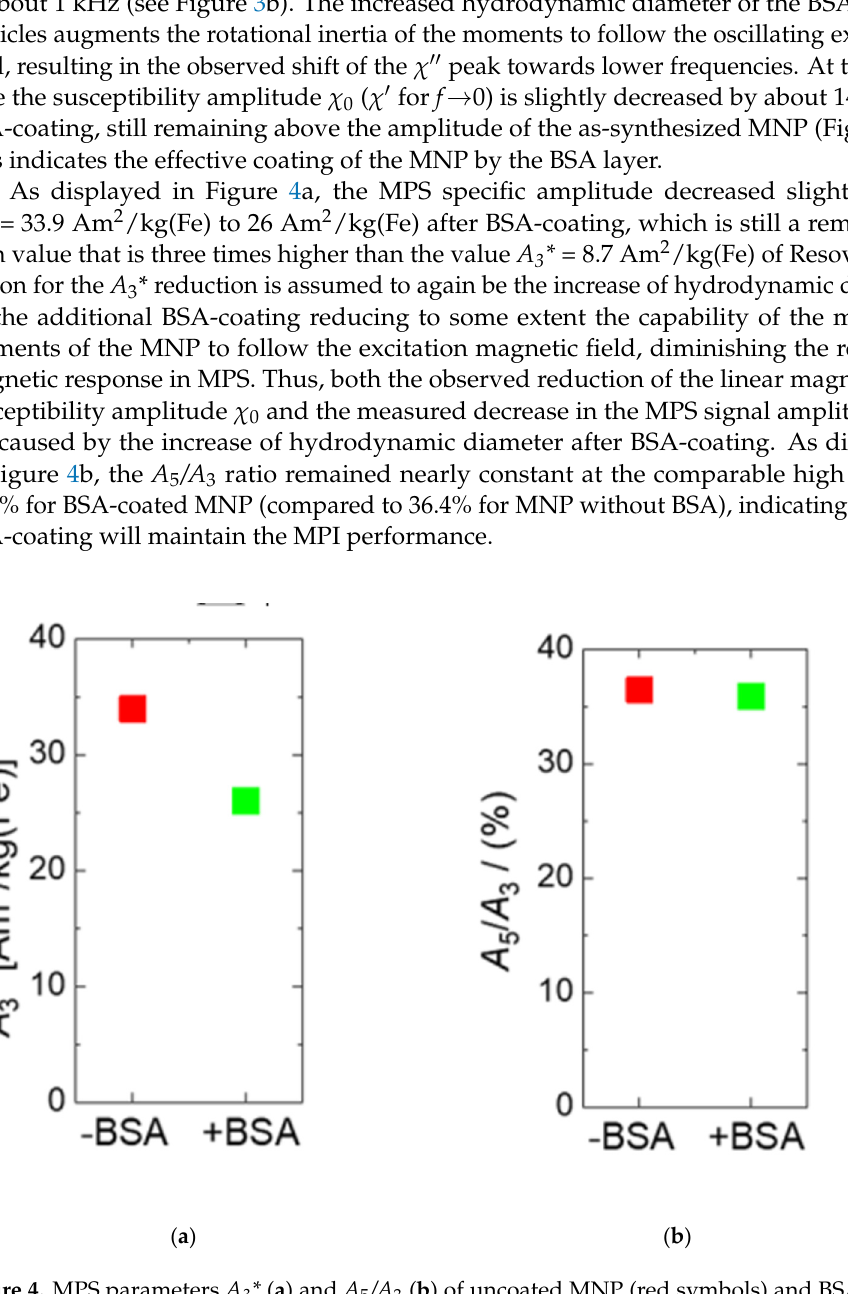
Figure 4. MPS parameters A 3 * ( a ) and A 5 /A 3 ( b ) of uncoated MNP (red symbols) and BSA-coated MNP (green symbols). The specific MPS amplitude A 3 * is reduced by about 20% while the shape parameter A 5 / A 3 remains nearly unchanged. This reduction is attributed to the increase in hydrody- namic diameter from 26.5 to 42 nm by BSA-coating.